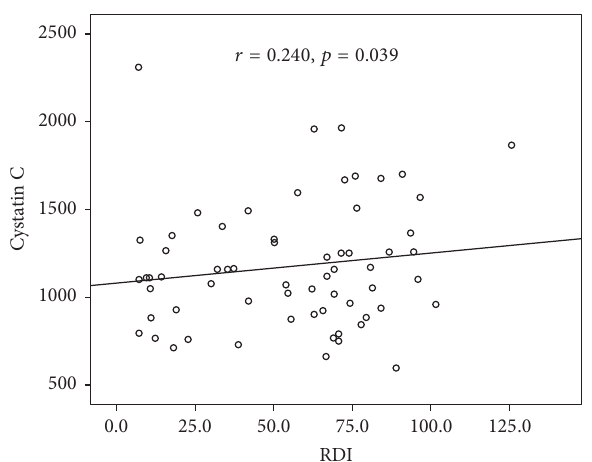
Figure 3: Correlation between Cystatin C levels and average oxyhaemoglobin saturation during sleep in OSAS patients.